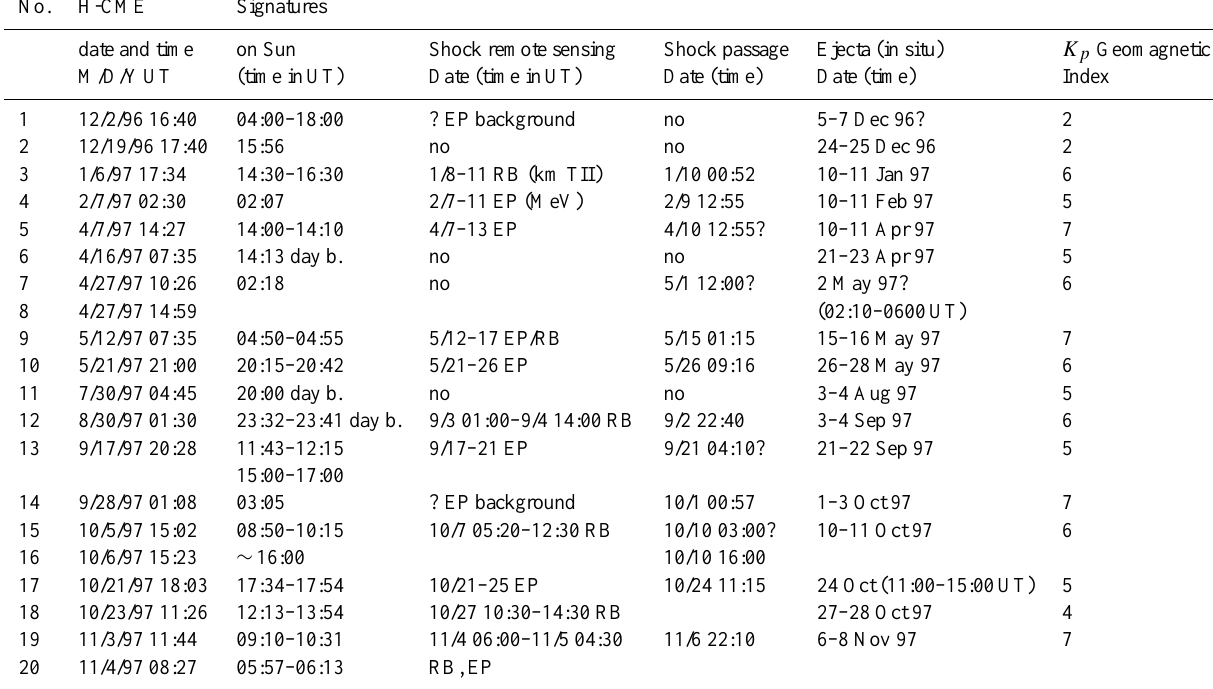
Table 1. Synoptic time-line of the Sun source of H-CME and the possible ejecta manifestations at 1AU